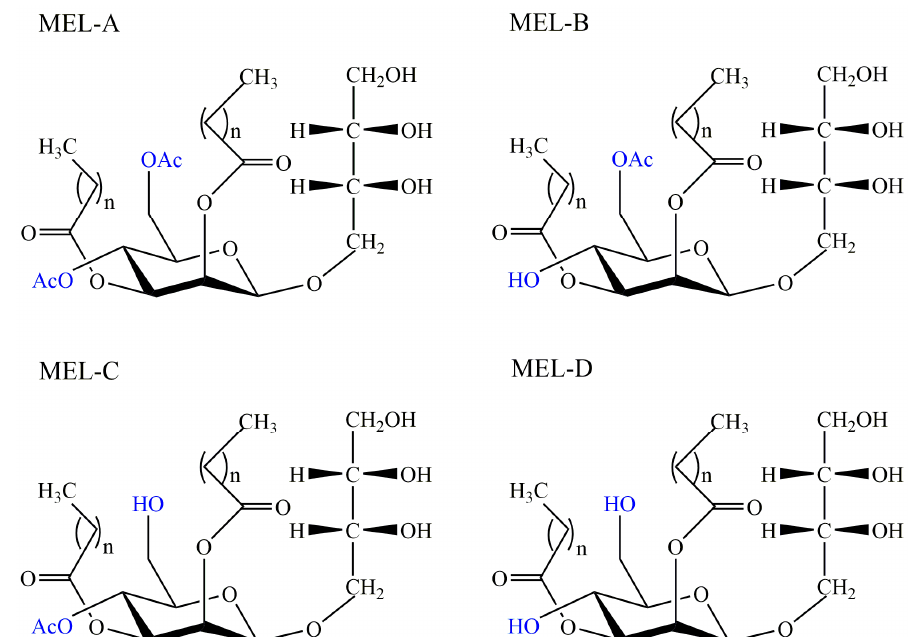
Figure 4. Different structures of mannosylerythritol lipids: Mannosylerythritol lipid (MEL)-A, MEL-B, MEL-C, and MEL-D, n = 2~18.